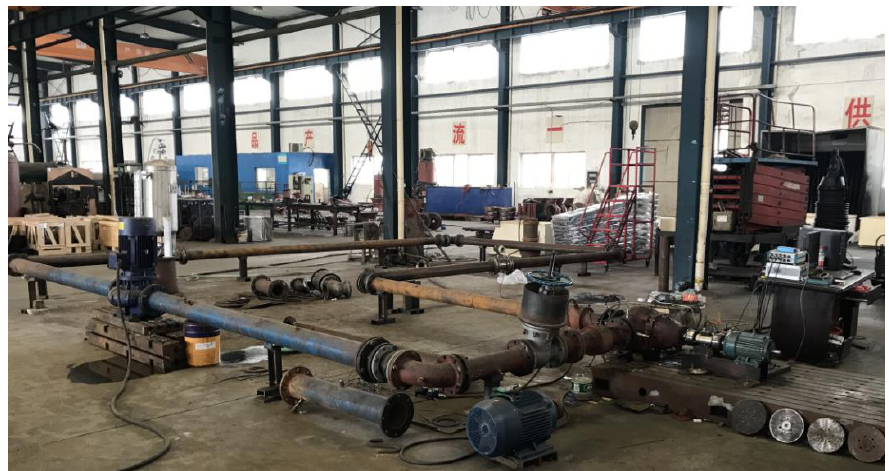
Figure 7. Site of the experiment table system.